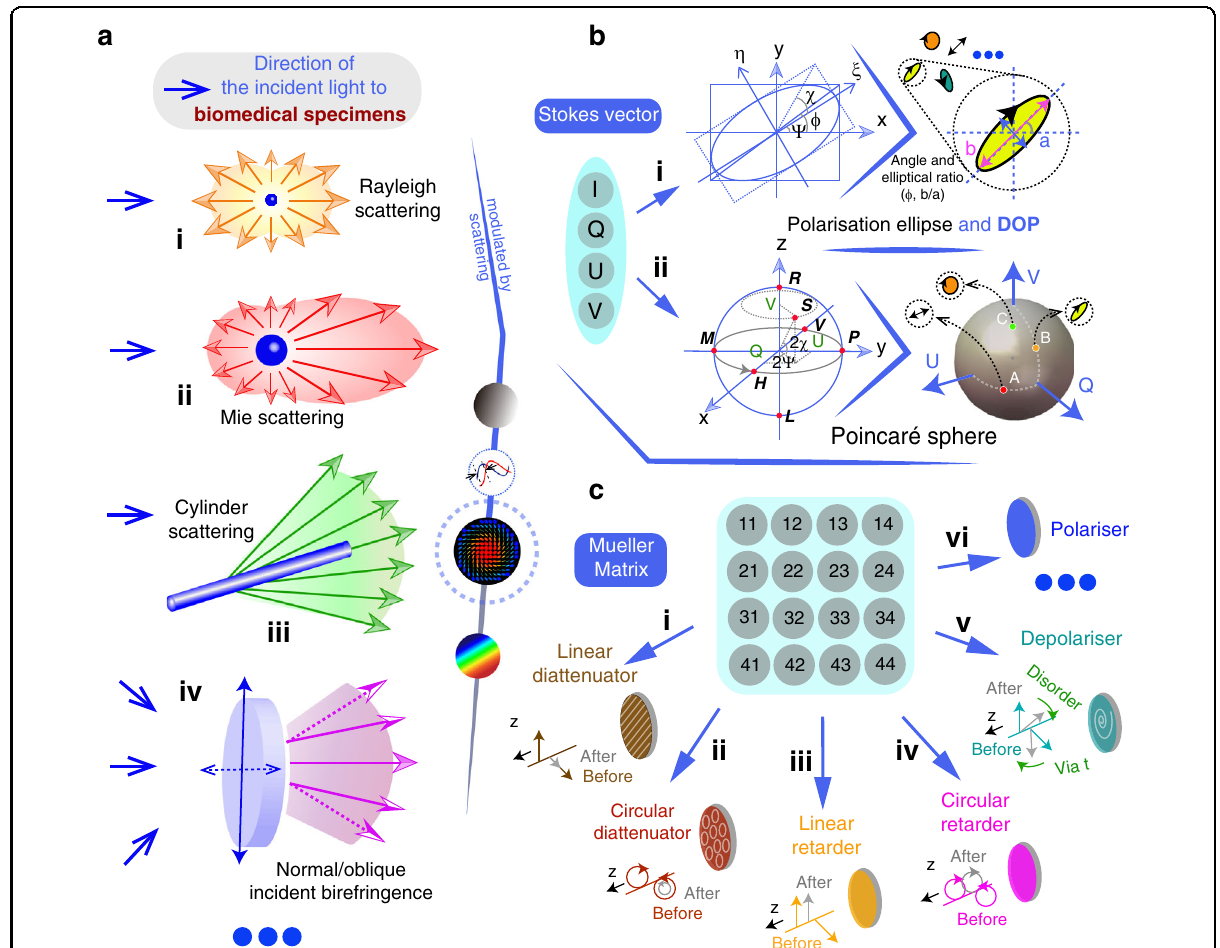
Fig. 2 Fundamental light-matter interaction processes in biomedical specimens and polarisation tools. a Several scattering types and media manipulation, showing schematically the way in which light is scattered in the differing scenarios 16 – 24 . b The Stokes vector representations. Top row: the polarisation ellipse and the DOP can be used to represent a given Stokes vector. Bottom row: the Poincaré sphere visualises all states of polarisation with linear states on the equator, circular states on the north/south poles and elliptical states in between 2 – 5 . c Vectorial properties that can be encoded in the Mueller matrix. Linear/circular diattenuator, linear/circular retarder etc. are fundamental polarisation elements; the arrows on the lines or circles represent the eigenbasis of modulated light beam passing through such media, where ‘ before ’ and ‘ after ’ illustrate the amplitude and/or relative phase change of the chosen eigenbasis. For further details refer to refs. 2 –